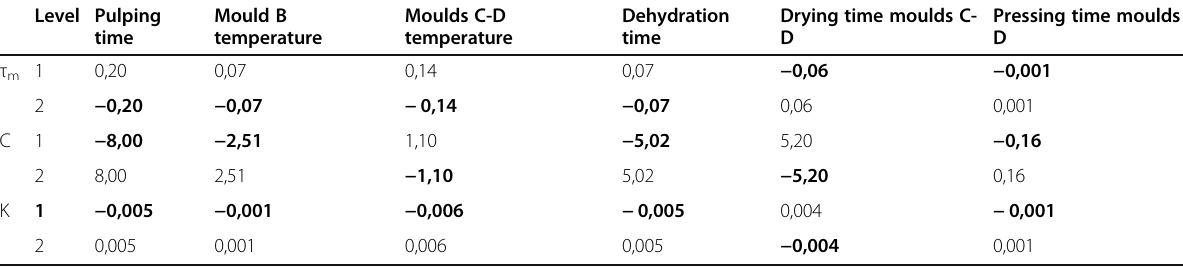
Table 5 Effect of process parameters on GAB model Variables τ m , C and K Level Pulping